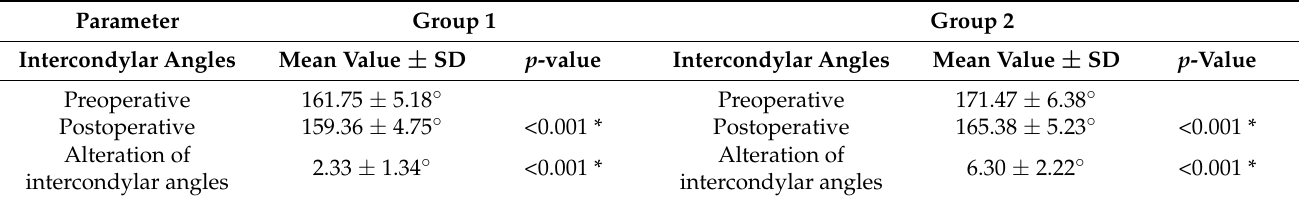
Table 4. The variation and alteration of intercondyar angles in the two